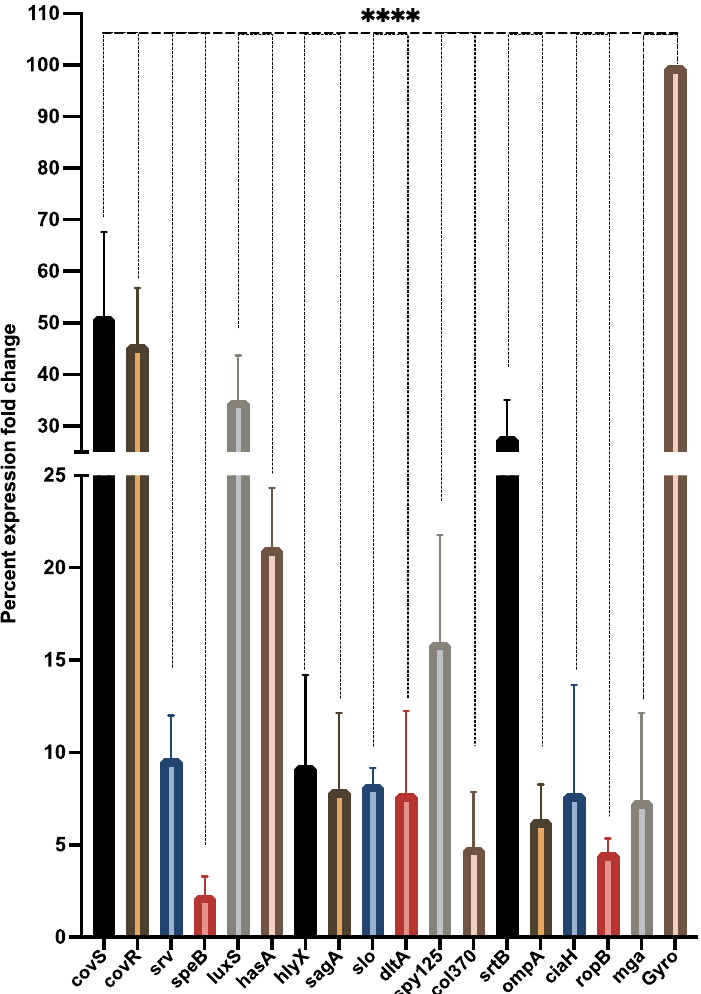
Figure 6. Percent expression fold change in biofilm and virulence-associated genes of S. pyogenes . The qPCR analysis demonstrated the modulatory effect of LME on the expression profile of target genes associated with biofilm and virulence in S. pyogenes . **** p value < 0.0001. In addition, the real-time PCR results also demonstrated the significant downregula- tion of genes which are critical for hemolysis, namely, sagA (responsible for streptolysin S synthesis), slo (responsible for streptolysin O synthesis), and hlyX (hypothetical protein responsible for hemolysis) upon LME treatment. This result was in agreement with the decrease in percent hemolysis as observed in hemolysin assay upon LME treatment. The genes covR and covS are involved in the covRS TCS pathway, and have been well studied for their role in regulating genes, including luxS (involved in quorum-sensing system), mga (a stand-alone regulator), and hasA (participant in hyaluronic acid produc- tion) [8]. Furthermore, the antioxidant property of LME has been uncovered by the